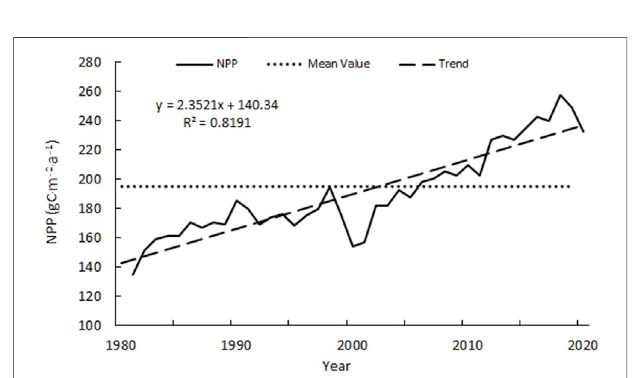
FIGURE 7 | Inter-annual variation of the NPP in the Yellow River Basin from 1981 to